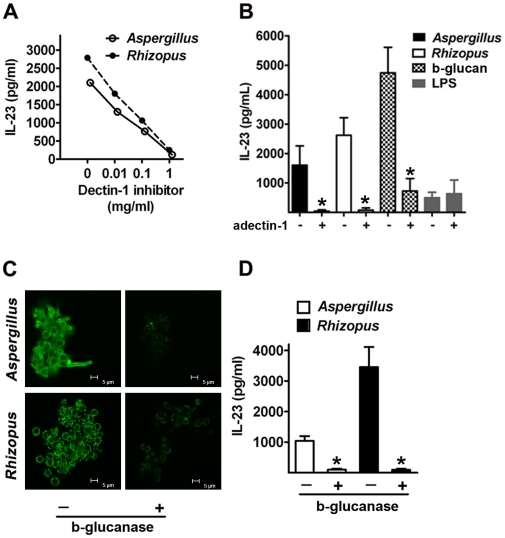
Induction of IL-23 producing DCs by opportunistic fungal pathogens is dectin-1 dependent and is mediated by b-glucan.(A) IL-23 production by human monocyte-derived DCs pre incubated for 1 h with increasing concentrations of the dectin-1 inhibitor laminarin (0, 0.01, 0.1, and 1 mg/ml) and subsequently stimulated with hyphae of either Aspergillus (open cycles) or Rhizopus (closed cycles), at a 1∶1 ratio. (B) IL-23 production by DCs stimulated with hyphae of either Aspergillus (black bars) or Rhizopus (white bars), or b-glucan (scattered bars) or LPS (gray bars) alone or following 1 h pre incubation with an anti-dectin-1 blocking antibody (10 µg/ml). Data are expressed as mean ± SEM values for DCs derived from three different donors. (C) Representative confocal microscopy images of b-glucan surface staining in hyphae of Aspergillus or Rhizopus untreated or following overnight enzymatic digestion with b-glucanase (10 U/ml). (D) IL-23 production by DCs stimulated with hyphae of Aspergillus (white bars) or Rhizopus (black bars) untreated or following overnight enzymatic digestion with b-glucanase. Data shown are representative of 3 independent experiments. Error bars represent SD. *, P<0.001, paired Student's t test.